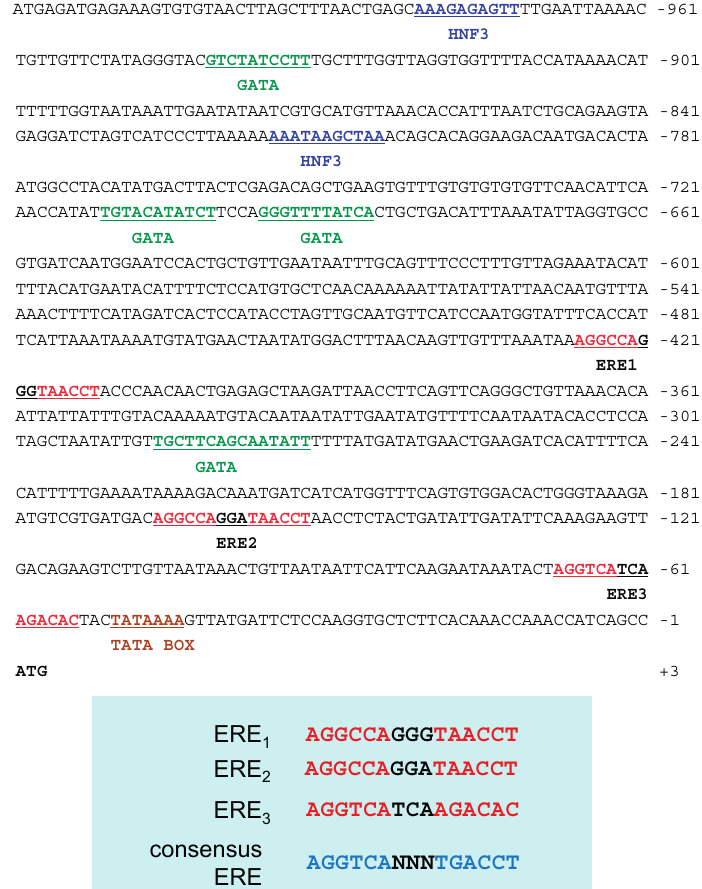
Figure 5. Sequence analysis of the 5'-flanking regions of the Ru-Vg gene. The locations of potential binding sites of HNF3 (blue), GATA (green), ERE (red), and TATA box (brown) are bold and underlined. HNF3 and GATA or ERE was found in threshold scores (default: 85.0 or 75.0), respectively. The A of the Ru-Vg start codon (ATG) is at the +1